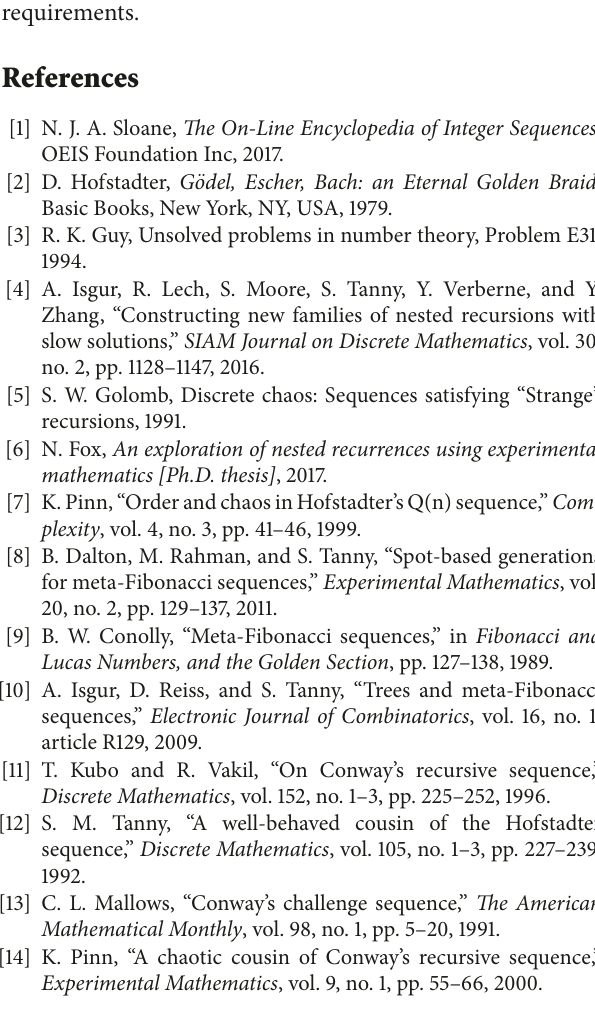
Figure 11: Graph of 𝑆 𝑏 (𝑛) for 80000 ≤ 𝑛 ≤ 95000 : small elliptic-like sausages appear in the connection of big sausages; more precisely, 𝐺(12) = 87288 exactly gives the position of juncture of evident small elliptic-like sausages.